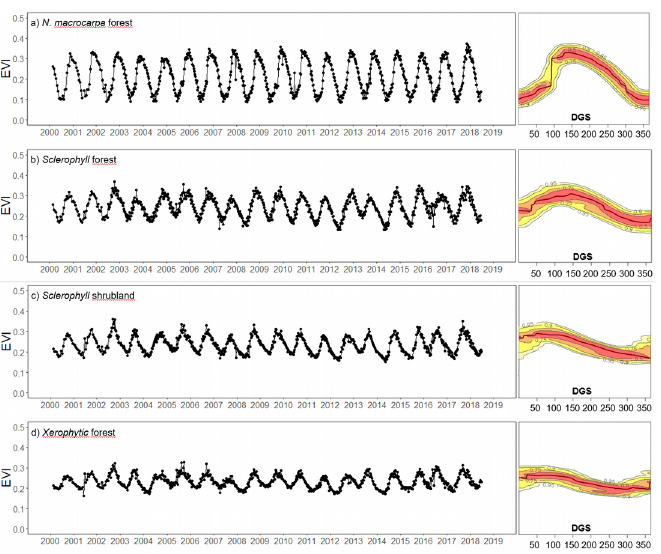
Figure 5 . EVI time series and long-term annual phenology (2000-2019) reconstructed using the median values of all pixels corresponding to four conservation targets (OdeC) of the La Campana National